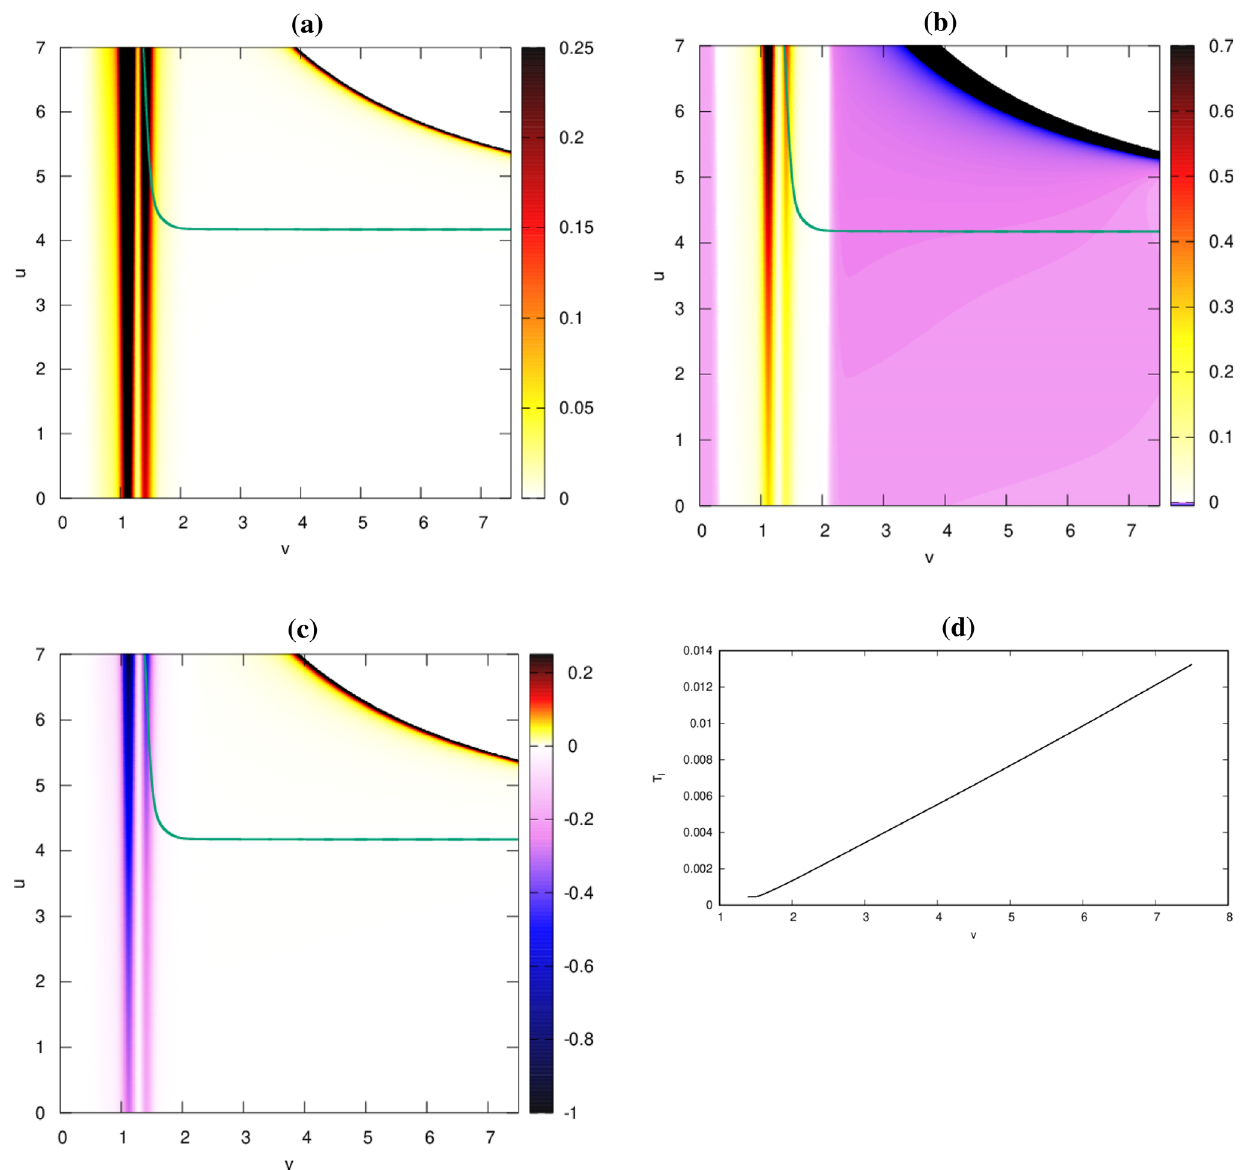
Fig. 7 The (v u ) -distribution of a energy density, ˆ ρ , b radial pressure, a dynamical evolution characterized by parameters λ X = λ hX = 0 . 1, ˆ p ˆ p m 2 = 0 . 25, ξ X = ξ h = 0, α m = 0 . 1 (the same as in Fig. 5) and the r , and c pressure anisotropy, a , and d local temperature along the black hole apparent horizon, T l , as a function of advanced time for field amplitudes ˜ p X = ˜ p h = 0 .